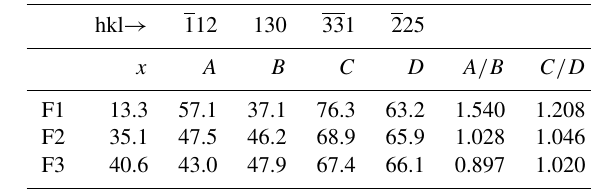
Table 8. Calculated relative intensities of selected hkl lines in the XRPD of fülöppite as a function of the Pb / Sb crossed-substitution coefficient x